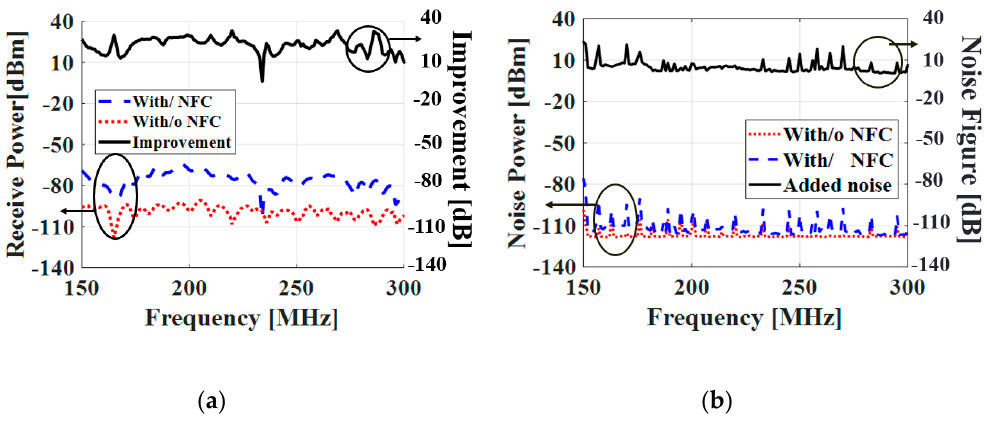
Figure 9. The measurement setup for signal-to-noise ratio measurement without and with the non-Foster circuit connected.